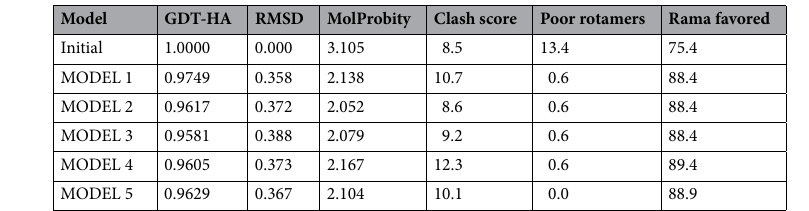
Table 5. Refine models value for multi-epitopes vaccine using GalaxyRefine 24